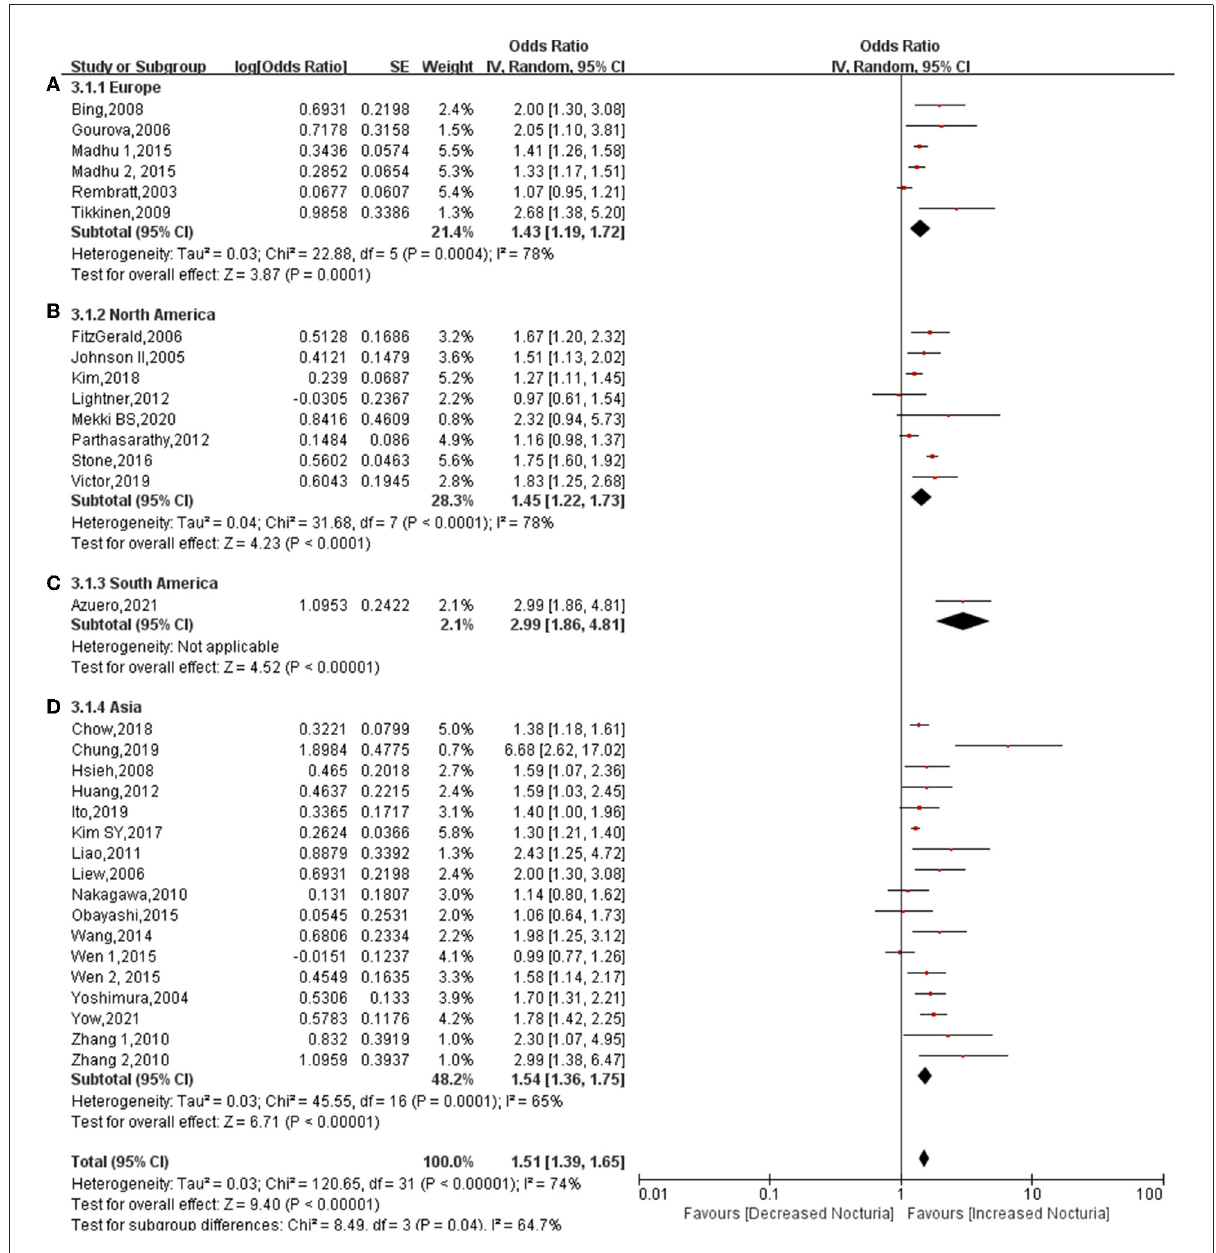
FIGURE4 Forest plot for the association between diabetes and nocturia stratified by country. Europe (A) , North America (B) , South America (C) , Asia (D)